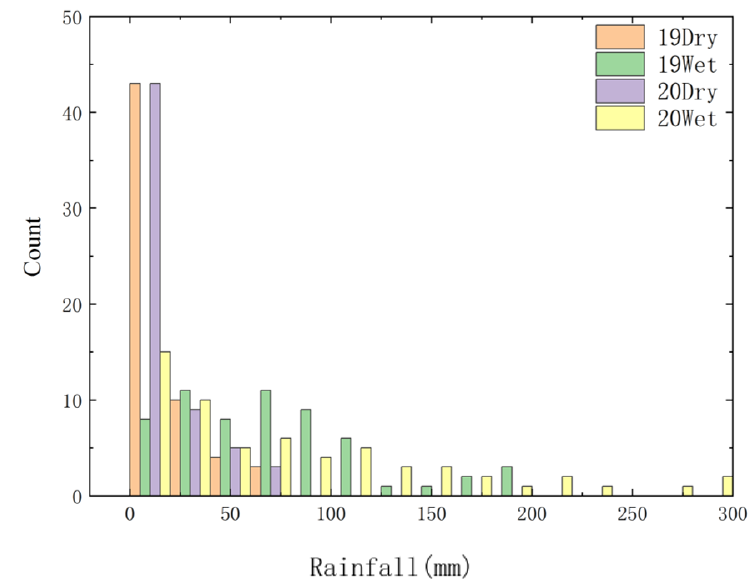
Figure 2. The average monthly rainfall of the canal in Henan Province.